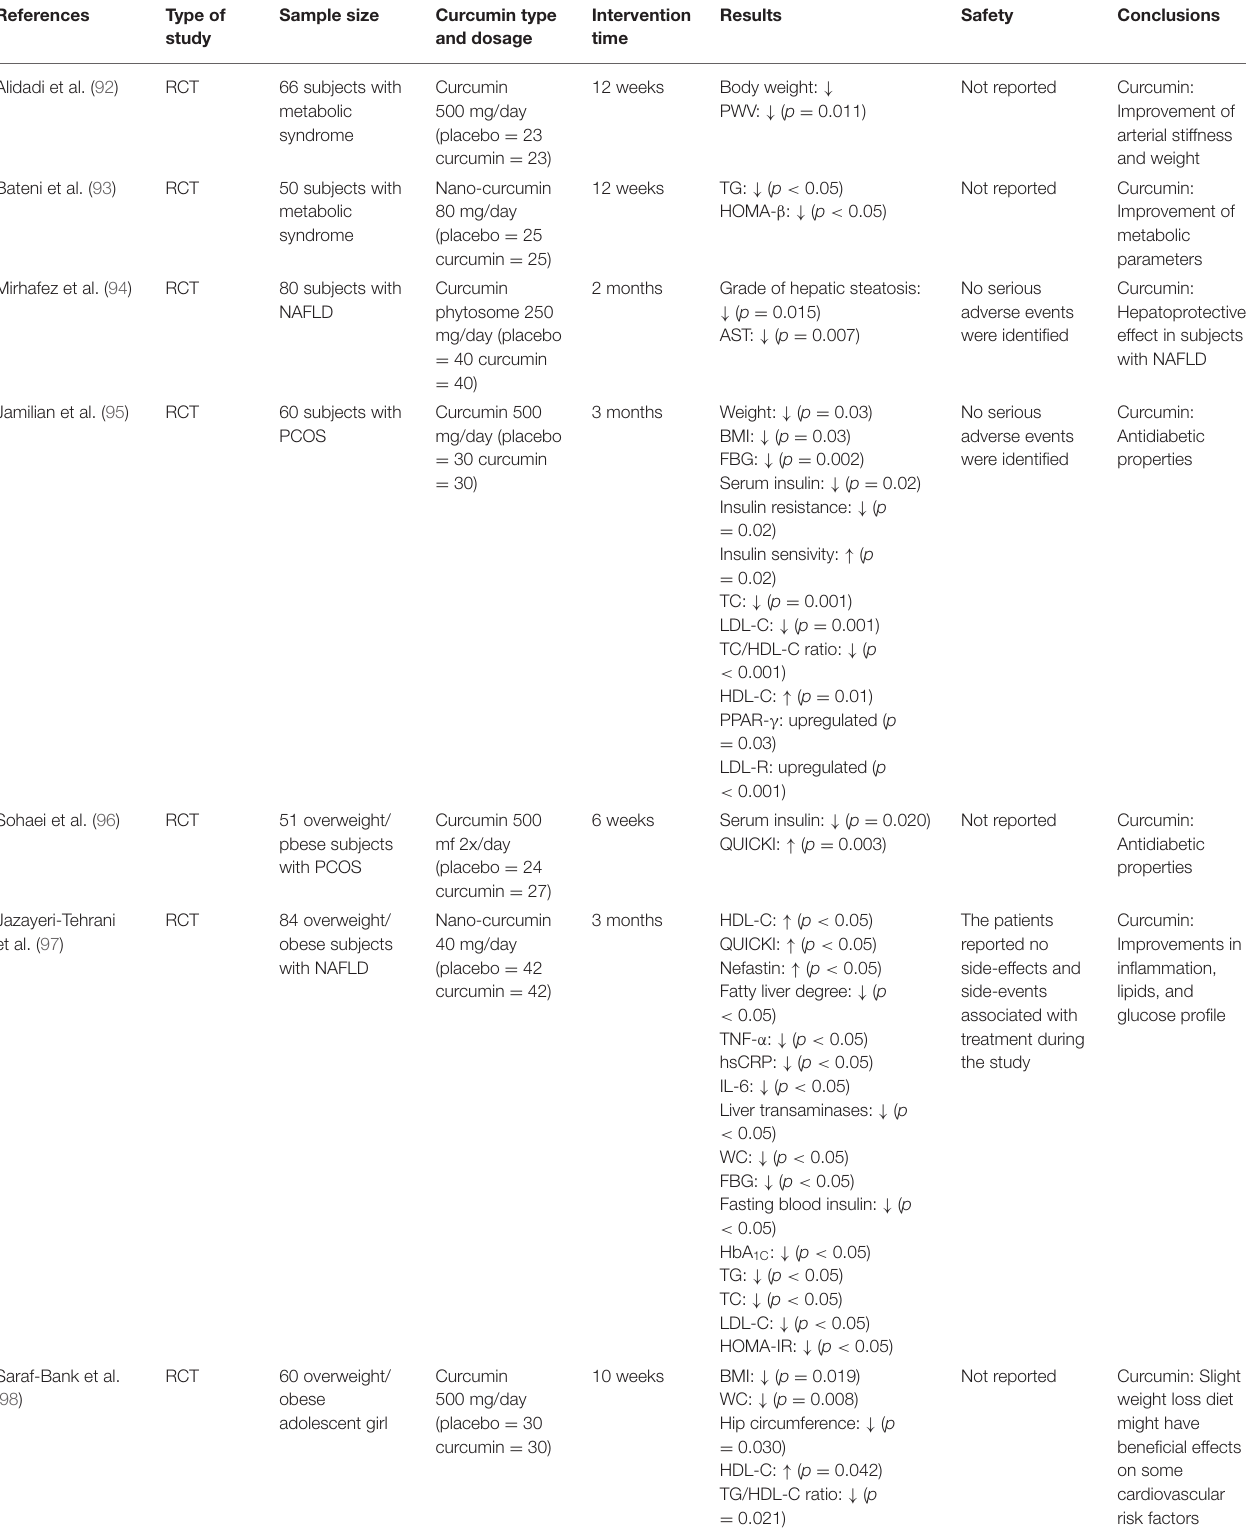
TABLE 3 | Summary of studies on the effects of curcumin on the obesity, metabolic syndrome, and obesity-related